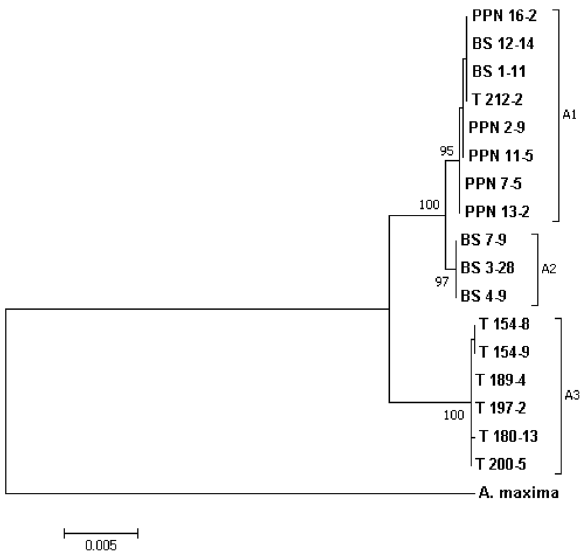
Figure 3. Phylogram resulting from maximum likelihood (ML) analysis based on combined data of all sequences and showing genetic similarity and differentiation between lineages A1, A2 and A3 of A. pinguis cryptic species A. Bootstrap values are given at branches. A. maxima was used as an outgroup for tree